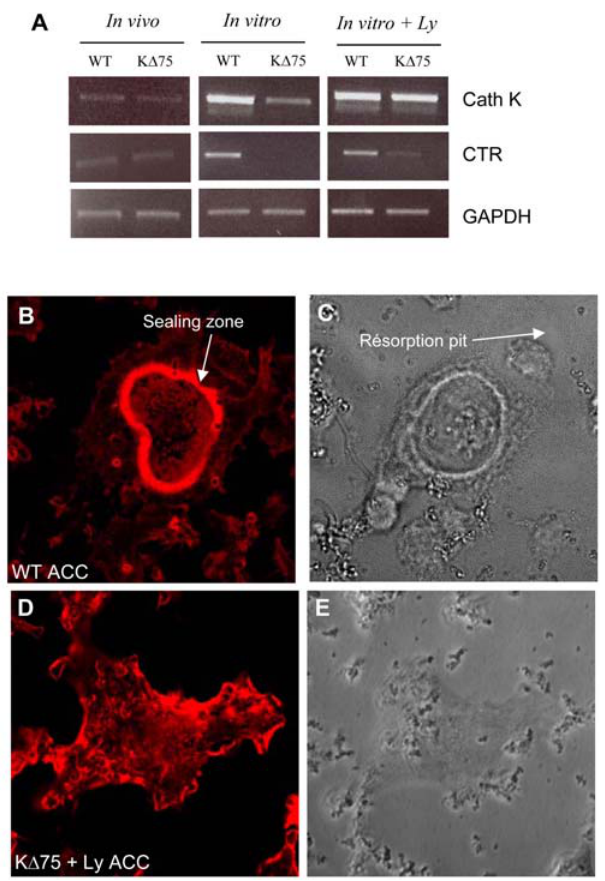
Figure 3. Lymphocytes trigger osteoclast marker expression but not bone resorption from K D 75 hematopoietic precursors. Expression of cathepsin K (Cath K) and calcitonin (CTR) receptors by RT-PCR. RNAs were extracted from WT and K D 75 mouse spleen cell cultures ( in vitro ) maintained for 7 days with MCSF and RANKL, with or without ( + Ly) lymphocytes. As a control, RNAs from WT and K D 75 mouse bones ( in vivo ) were also used. Under in vivo conditions, both Cath K and CTR were expressed in WT and K D 75 mouse bones, as well as in in vitro cultures from corresponding spleen cell cultures. However, in the absence of lymphocytes in in vitro cultures, Cath K is weakly expressed and CTR is absent from K D 75 mouse cell cultures. (B–E) Functional resorption tests on mineralized ACC matrix. Osteoclasts were differen- tiated in Petri dishes from WT and K D 75 mouse spleen cells in the presence of lymphocytes, and then removed before being plated on ACC matrix. After 24h, cell cultures were fixed and stained with phalloidin (B, D) and their resorption ability was evaluated by the formation of pits (C, D). WT osteoclasts on ACC matrix exhibited a typical actin-containing sealing zone associated with resorption (B, C white arrow). In contrast, actin from K D 75 derived osteoclasts did not form a sealing zone but was mostly arranged in lamellipodia (D) and these did not resorb apatite (E).